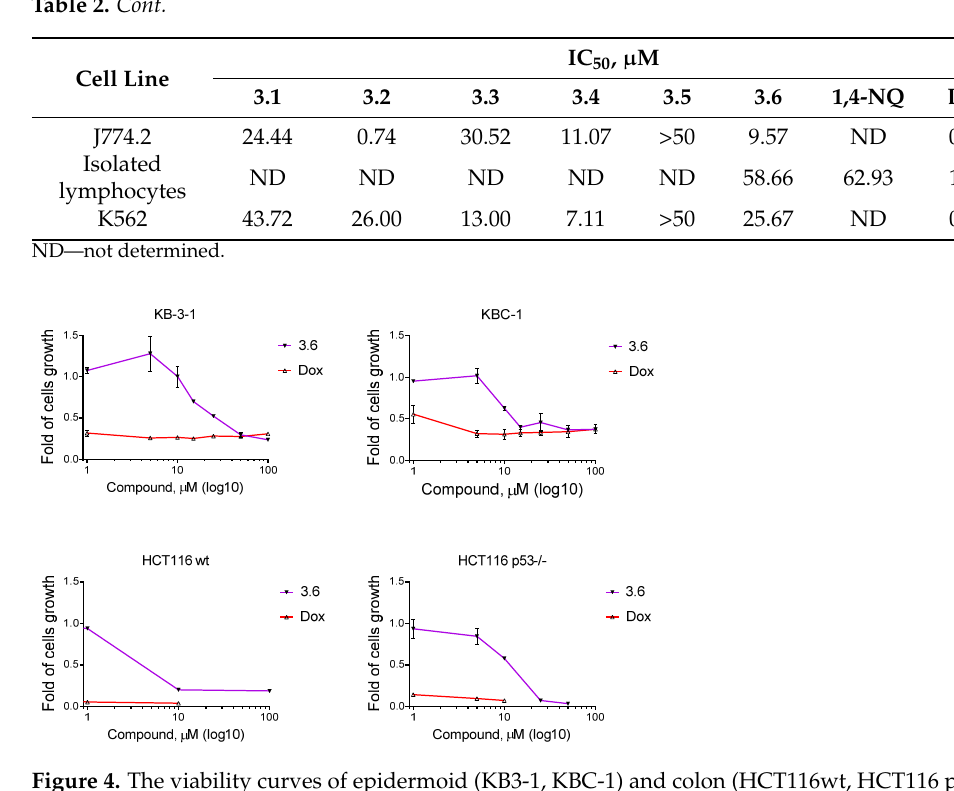
ND—not determined.